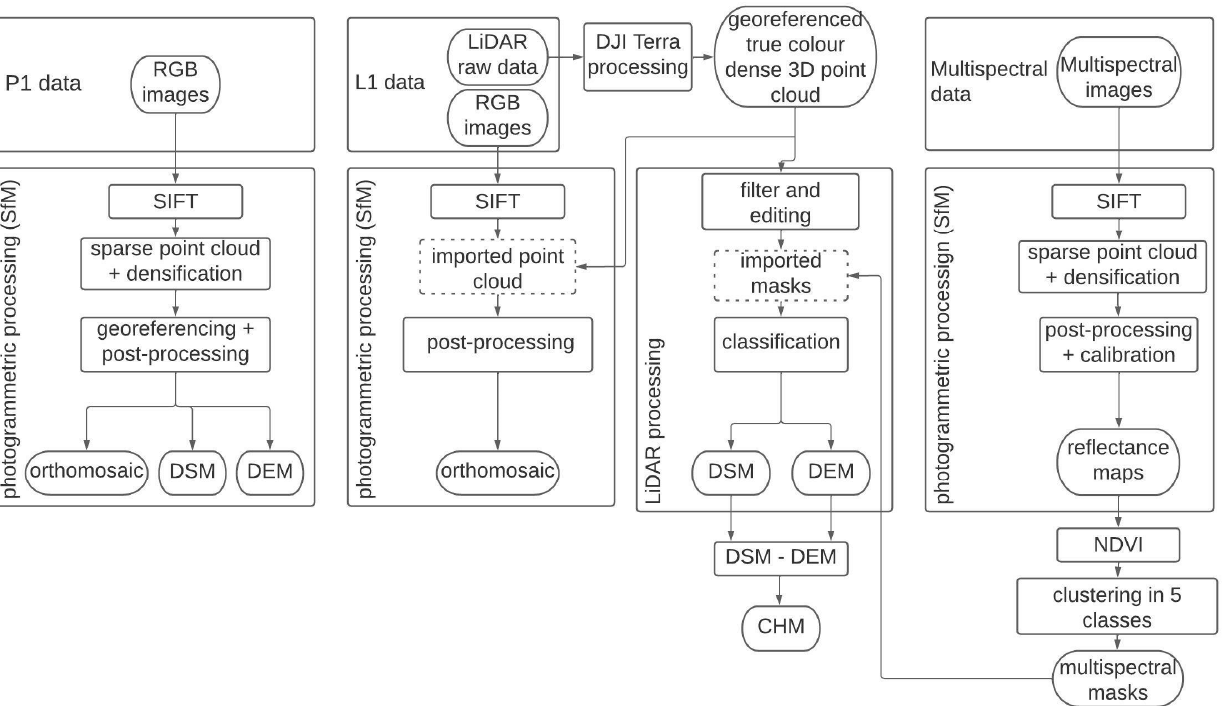
Figure 4. Flowchart showing the main data collected by the UAV sensors and their processing steps (photogrammetric camera on the left, LiDAR in the middle, and multispectral sensor on the right). The multispectral data allows the creation of masks for correctly classifying the plants in the point cloud. When multispectral imagery is missing, the imported mask step is absent in LiDAR data processing. Rectangular panels represent processing steps; rounded panels represent products.